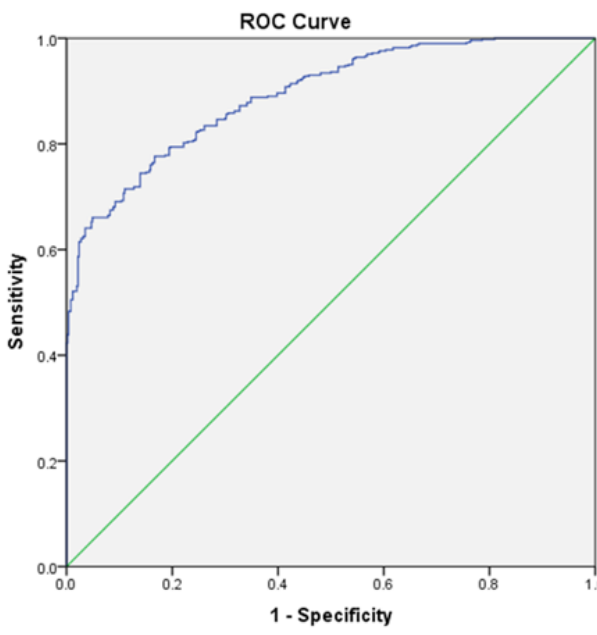
Fig. 1 – Receiver operating characteristic (ROC) prediction model for longer stay than 55 hours (area under the